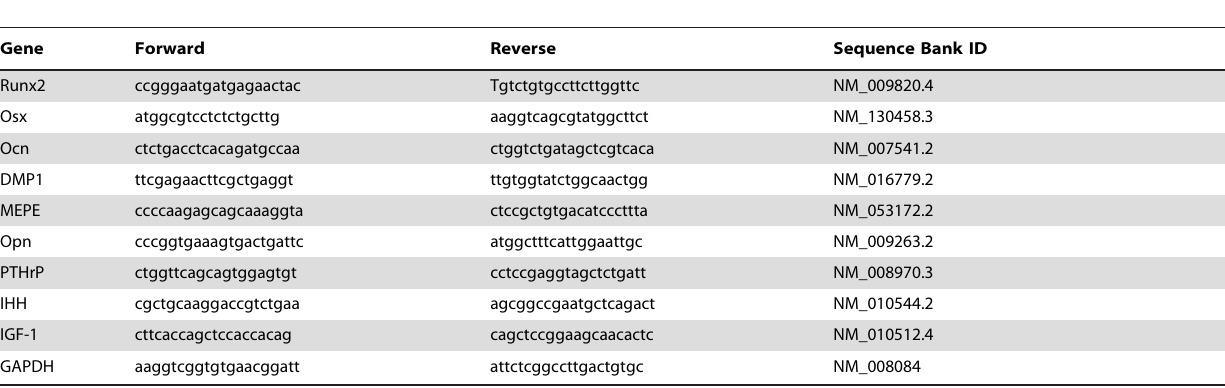
Table 1. PCR primer sequences in 5 9 -3 9